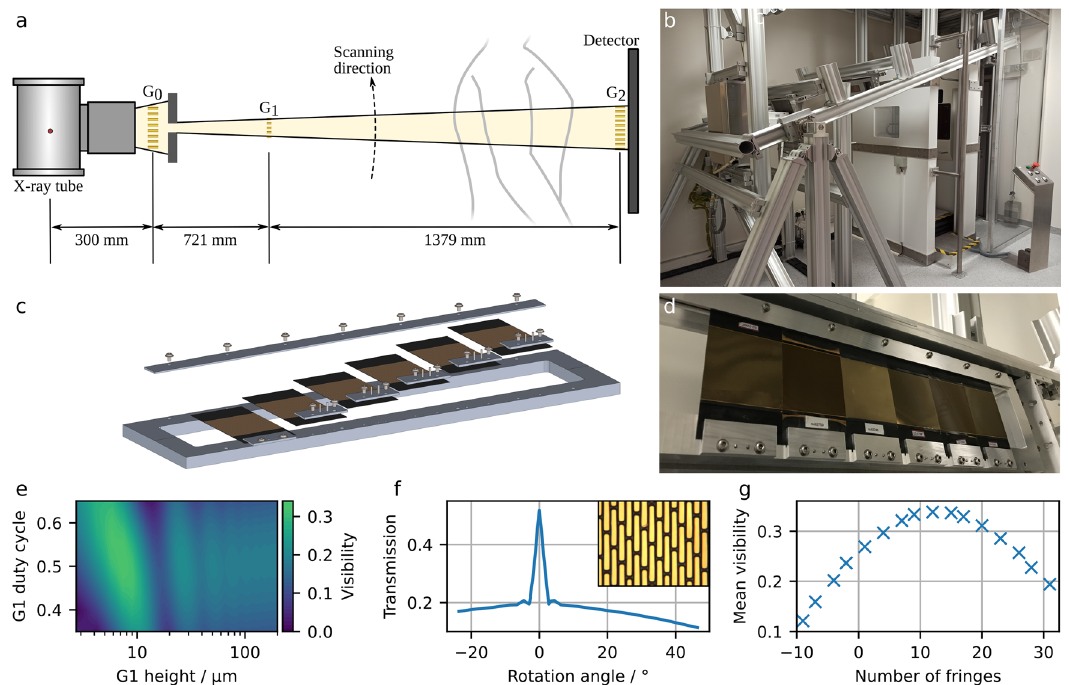
Fig. 2 Design and implementation of the dark- fi eld chest X-ray prototype. a Schematic and b photograph of the prototype system, combining a conventional radiography setup with a three-grating X-ray interferometer. c Schematic and d photograph of the G2 grating holder allowing individual positioning of the gratings as well as bending of the gratings according to the cone-beam geometry. Bending prevents the shadowing of the gold bars of the high aspect ratio gratings. e Simulated visibility for optimising of grating parameters such as duty cycle and height. The optimisation was carried out iteratively for all three gratings. f Angular X-ray transmission measurements and scanning electron microscopy image (inlet) for one of the grating structures. g In fl uence of a number of fringes per frame on mean interferometric